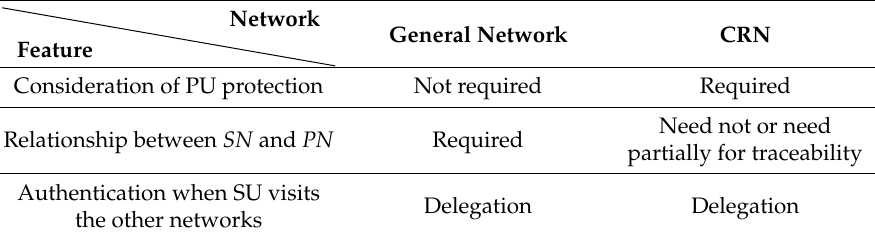
Table 2. Comparison of required security features in